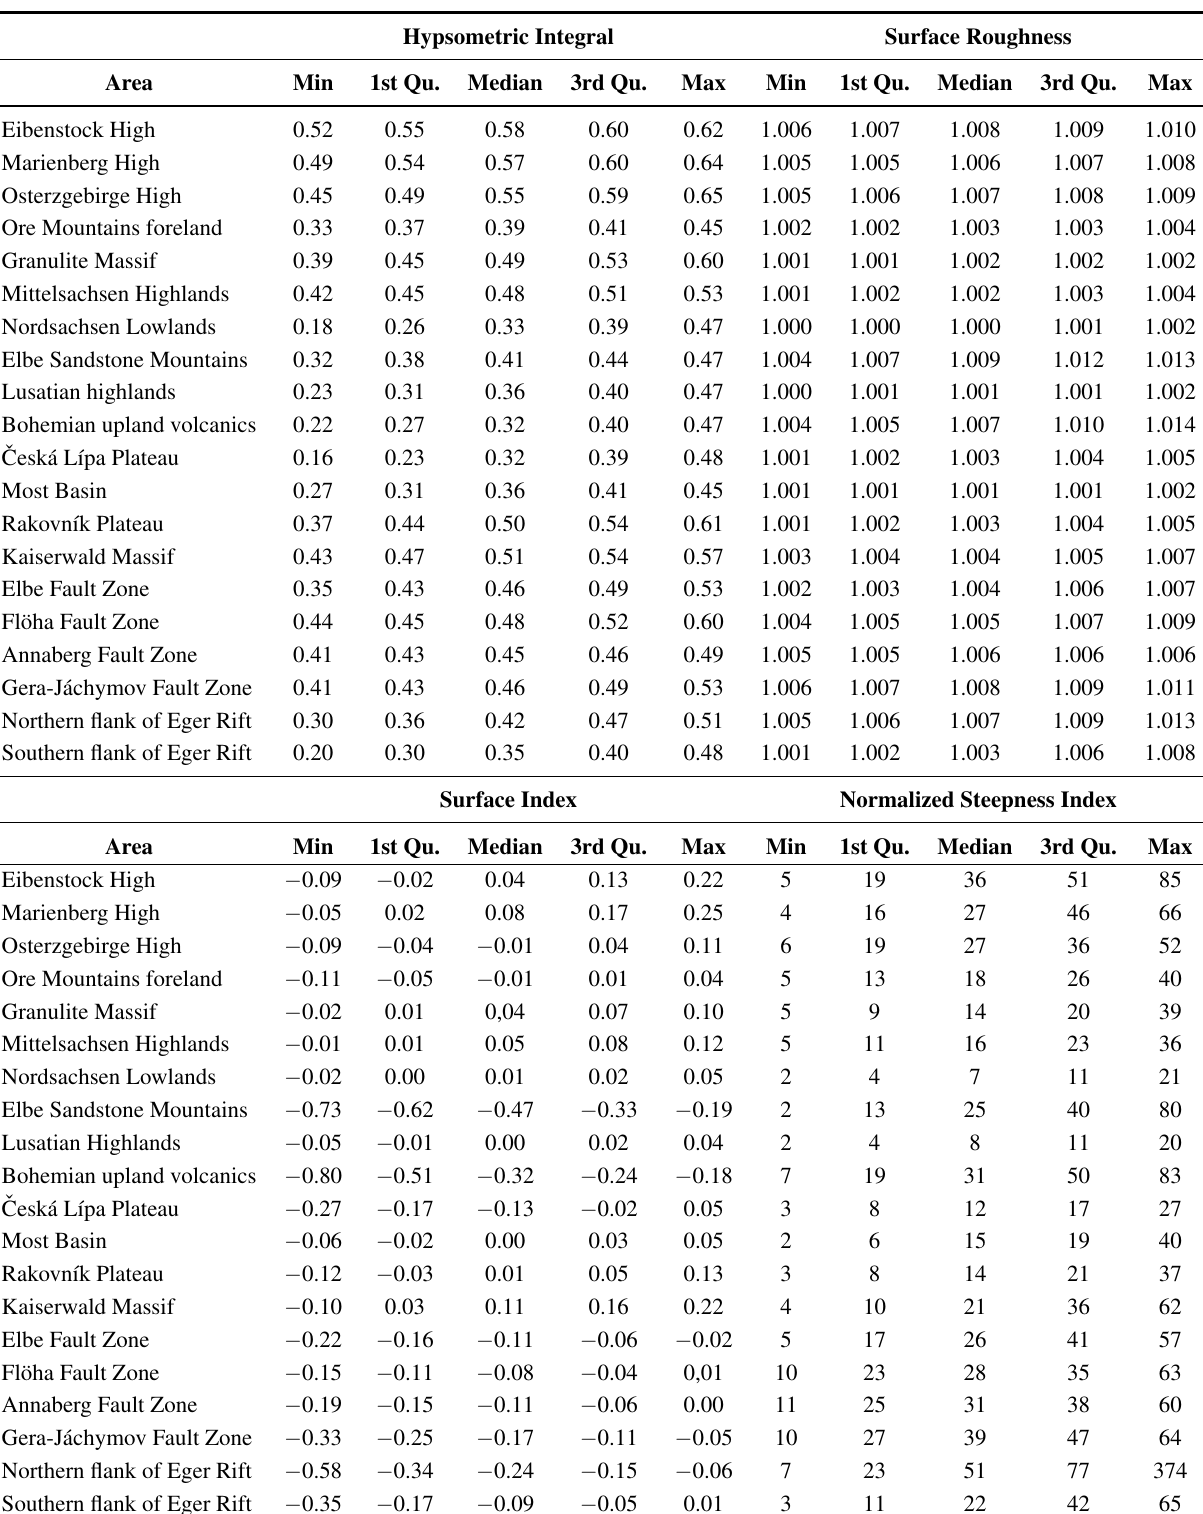
Table 1. Summary of computed geomorphic indices. We extracted pixel values and normalized steepness indices ( k ) for main surfaces and faulted areas discussed in the sn text (see the locations in Figure 2). Values were classified using quantiles